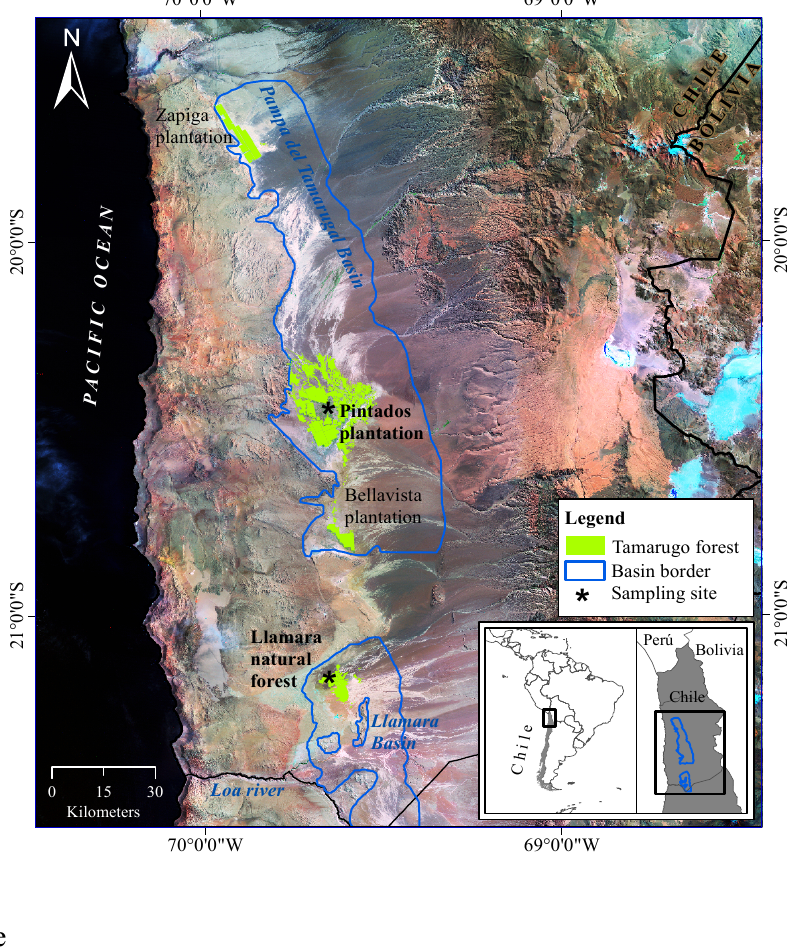
Figure 1. Satellite image (Landsat mosaic, USGS) of Pampa del Tamarugal in the Atacama Desert, Chile. Asterisks show the two sampling sites in the Pintados plantation and Llamara natural